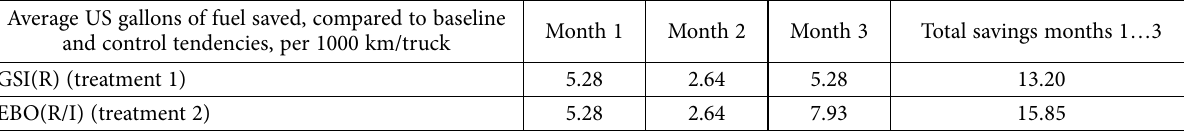
Table 4. Average fuel savings in [US gal/1000 km] Average US gallons of fuel saved, compared to baseline and control tendencies, per 1000 km/truck